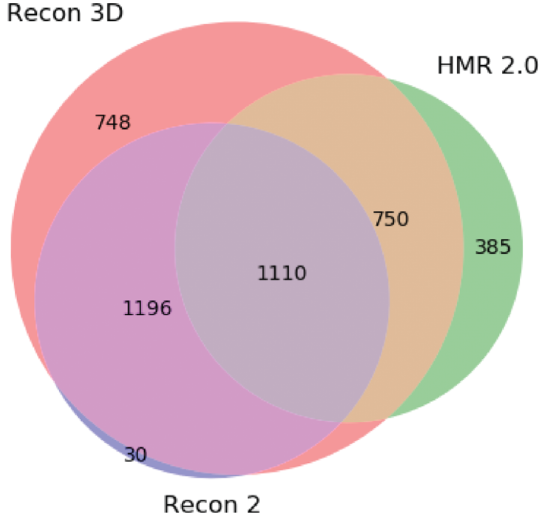
Figure 5: Venn diagram showing the integration of the Recon3D, Recon2 and HMR2.0. The numbers represent the amount of clusters with metabolites from each model, as well as clusters that integrate two or more